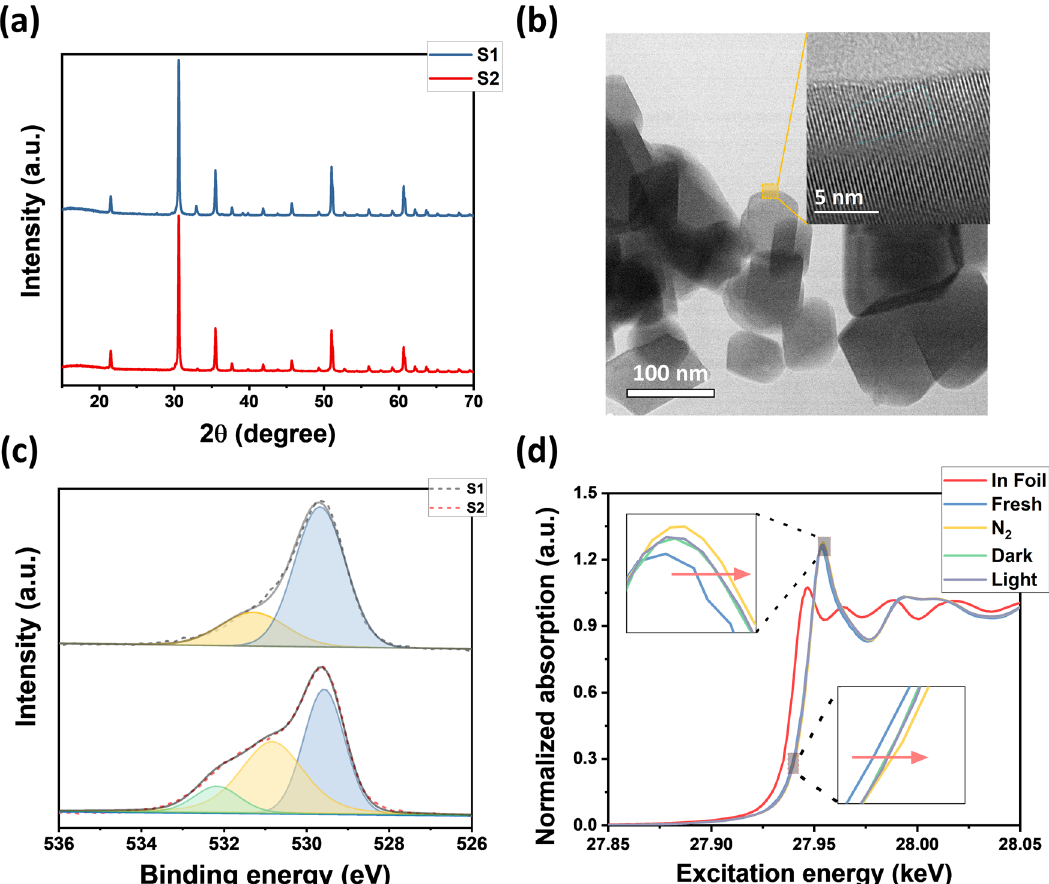
Fig. 1 Structural characterizations. a Powder XRD patterns of S1 and S2. b TEM image of S2 and high-resolution TEM image inserted in the upper right. c High-resolution O 1s core level XPS spectrum of S1 and S2 (the dashed line is the original XPS spectra, and the solid line is the best fi t results). d In situ XANES of S2 catalyst under different